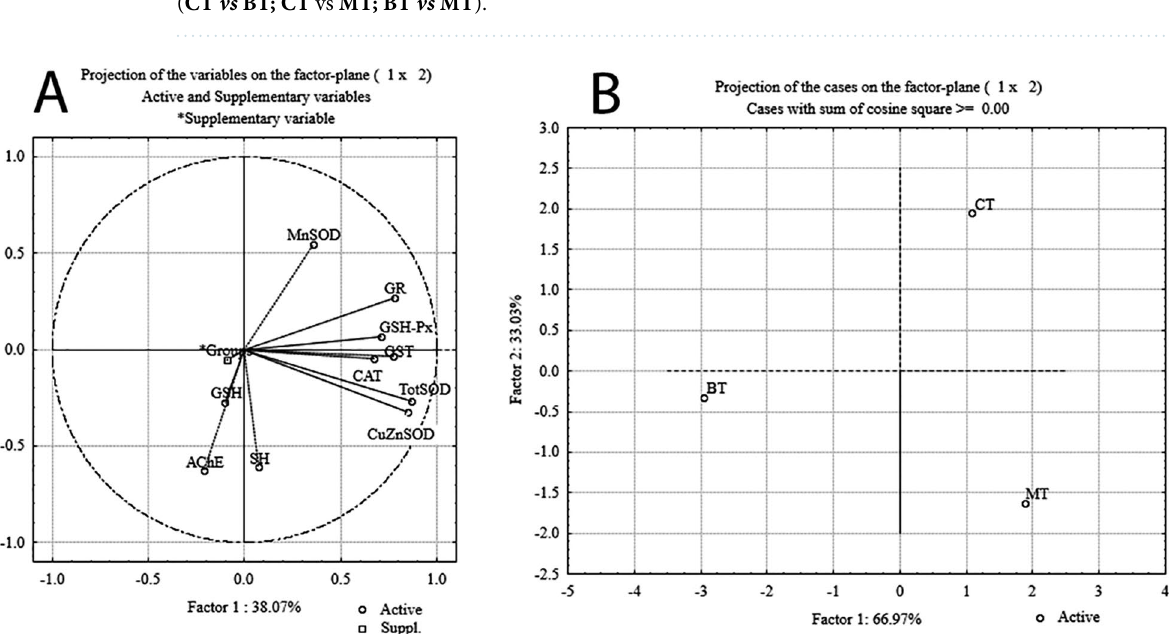
Table 1. The activities of total, Mn- and CuZn-containing superoxide dismutase (TotSOD, MnSOD, CuZnSOD), catalase (CAT), glutathione peroxidase (GSH-Px), glutathione S-transferase (GST), glutathione reductase (GR), and acetylcholinesterase (AChE), and the concentrations of glutathione (GSH) and sulfhydryl groups (SH) in control brain tissue (CT), benign tissue (BT) and malignant tissue (MT). The data are expressed as the mean ± SE. One-way ANOVA and post hoc Fisher’s LSD test for equal N, with P < 0.05 as the level of significance were performed. Significant differences between groups are marked in bold and with an asterisk ( CT vs BT; CT vs MT; BT vs MT ).